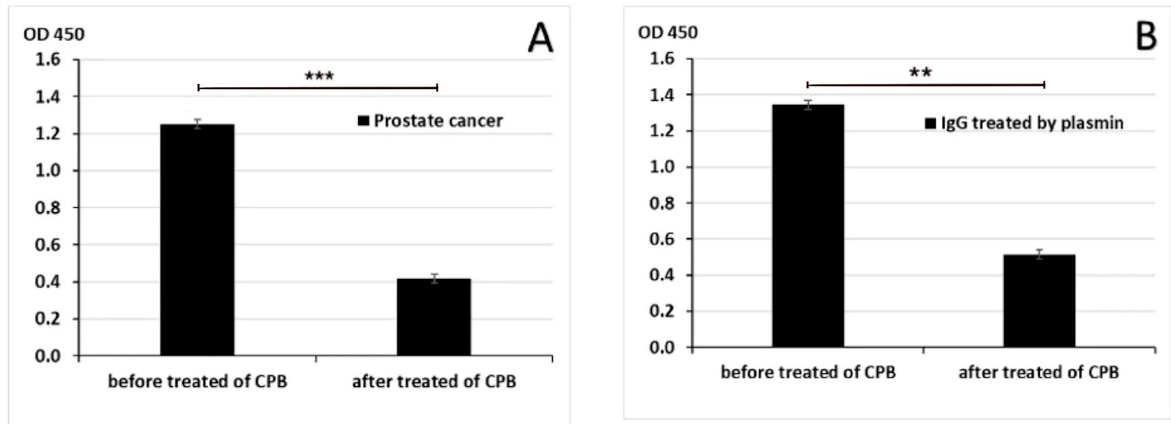
Figure 5. Binding of IgG to PLG-H after removal of C-terminal lysine. CPB inhibited the binding of IgG to PLG-H in PC samples ( A ) and in samples of purified IgG treated with PM ( B ). The experiment was repeated 3 times. **, p < 0.01; ***, p < 0.001.